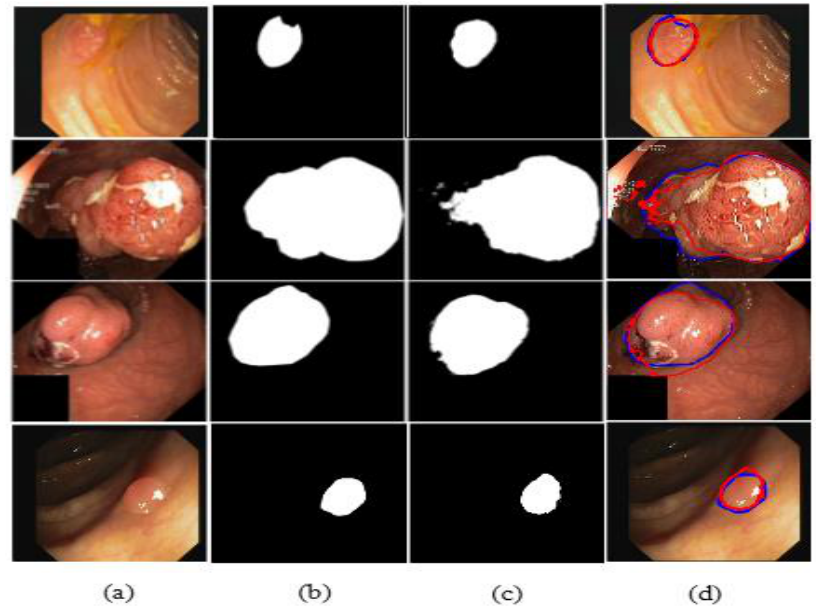
Figure 11. Comparison of ground truth and output mask on the Kvasir-SEG dataset. ( a ) Original Image; ( b ) ground truth; ( c ) output mask; and ( d ) combined.